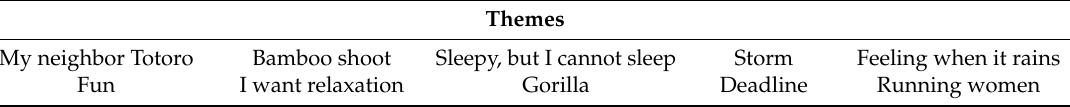
Table 1. Themes in experiments voluntarily chosen by each subject.